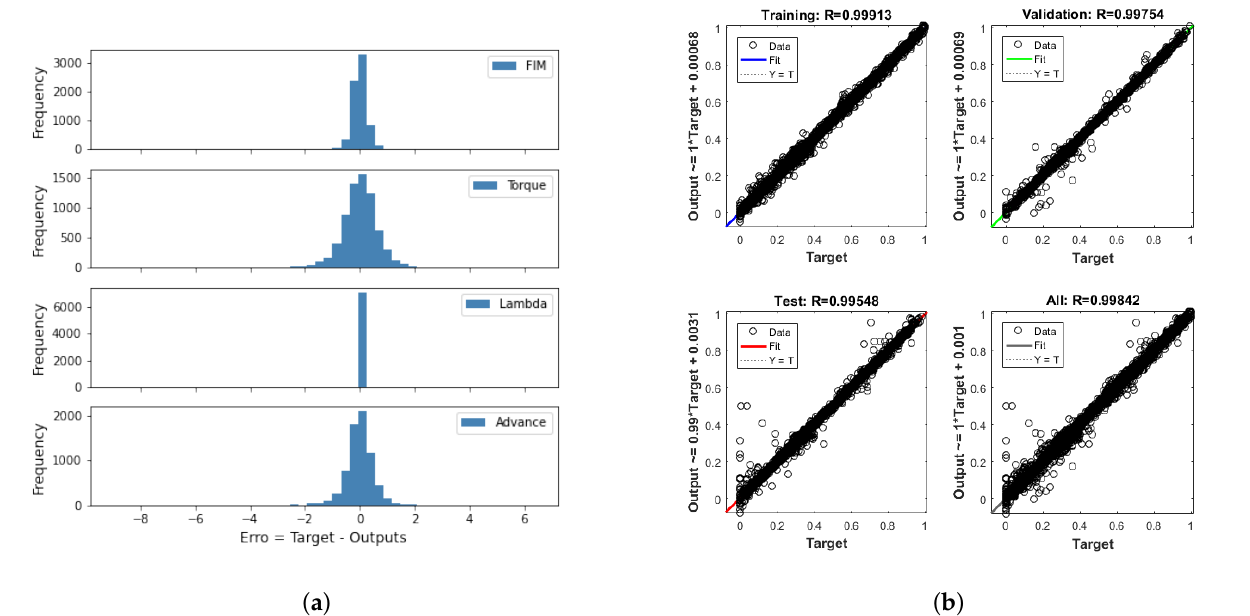
Figure 9. ( a ) Histogram of errors and ( b ) regression during ANN training using the Levenberg– Marquardt